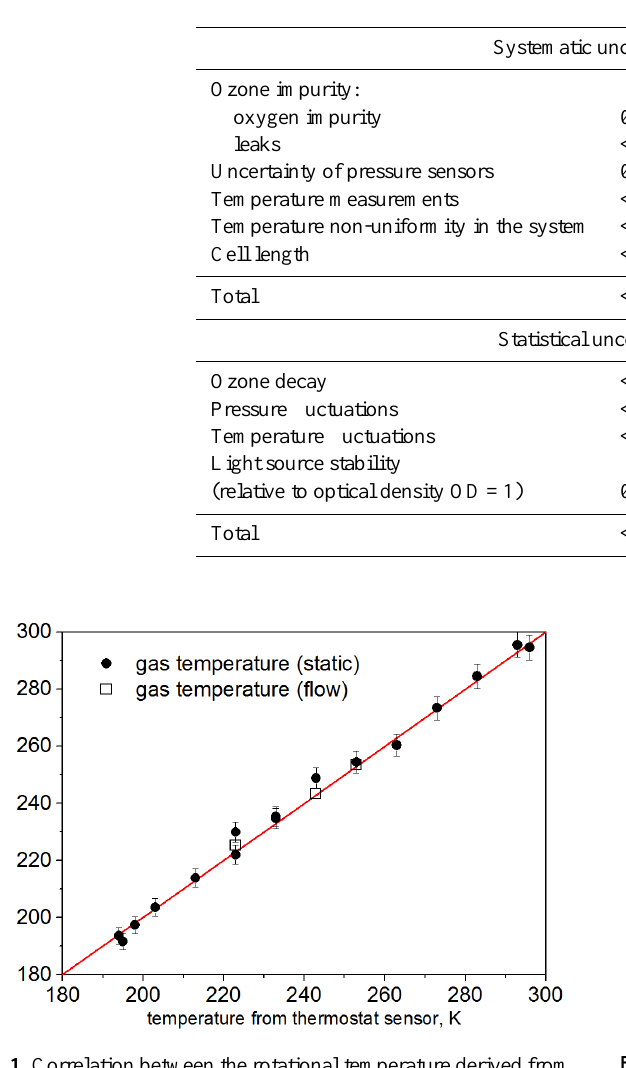
Table 2. Uncertainty associated with the absorption cross-section obtained from absolute measurements at 50mbar and 193–293K and path lengths of 135 and 270cm in the Huggins and Chappuis bands.